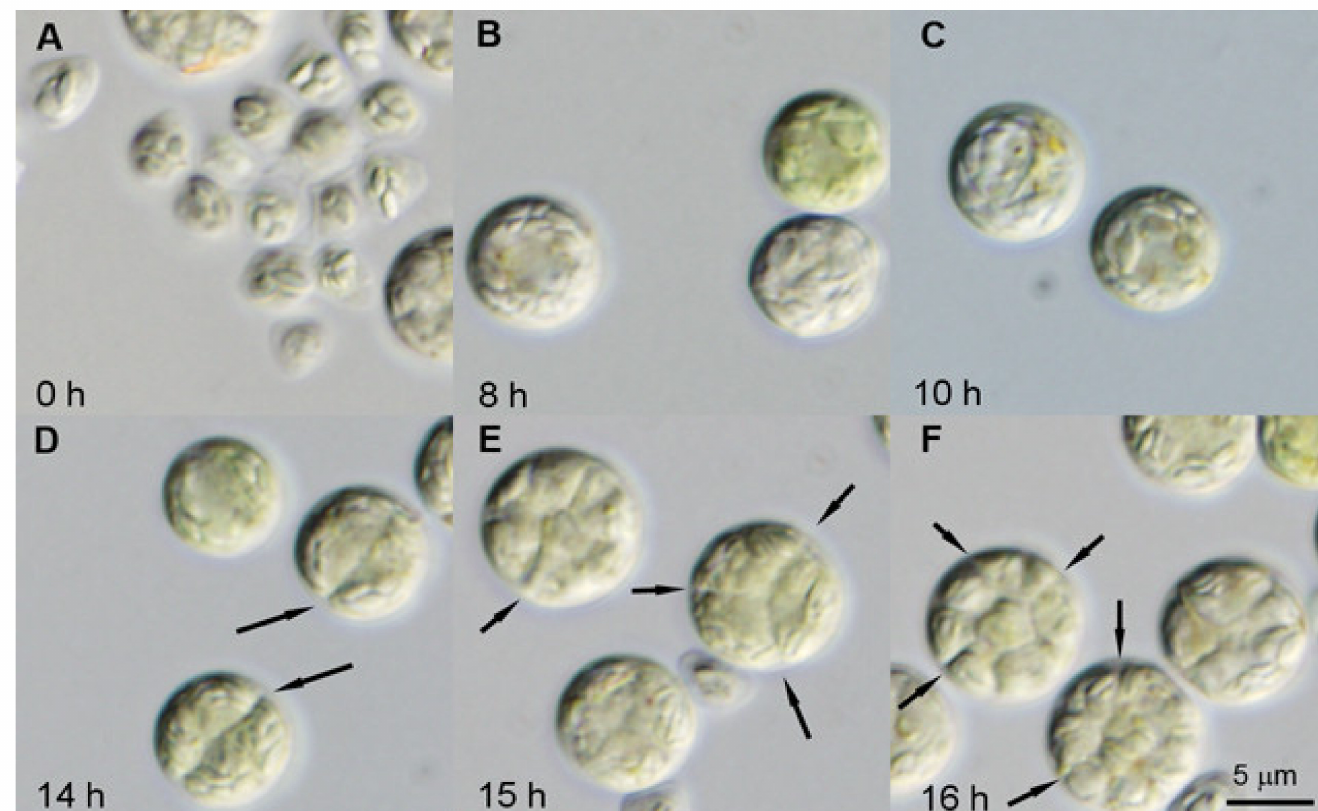
Figure 3. Course of cell cycle progression in synchronized cells of Parachlorella kessleri grown at a light intensity of 250 µ mol photons m − 2 s − 1 and a temperature of 30 ◦ C. Light photo-micrographs of daughter cells at 0 ( A ), 8 h ( B ) and 10 h ( C ) and mother cell dividing their protoplast into 2 (( D )—14 h), 4 (( E )—15 h), and into 8 (( F )—16 h). Division furrows are marked by arrows. Scale = 5 µ